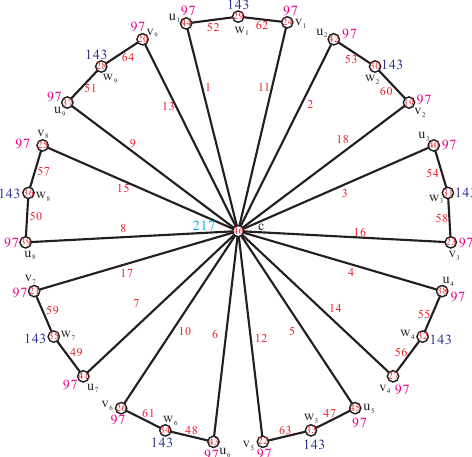
Figure 9. The local antimagic total labeling of D 9